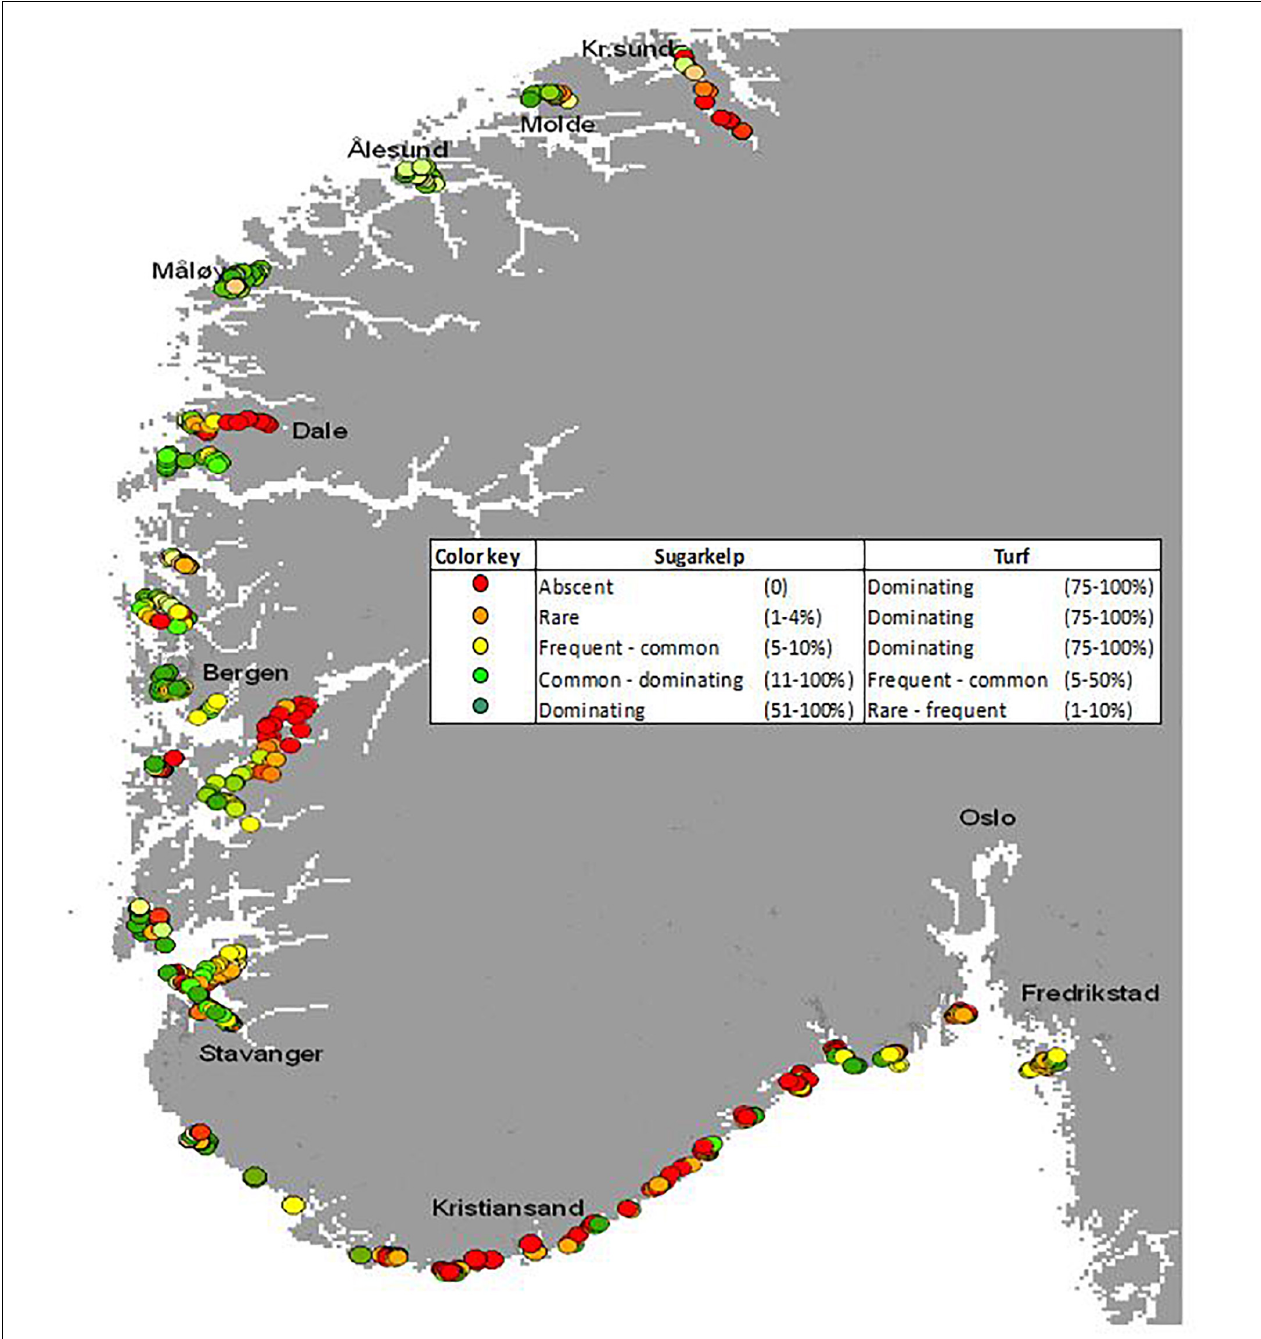
FIGURE 2 | Substrate coverage of both S. latissima and turf algae was recorded at more than 600 sites on the southern coast of Norway in the period 2005–2008. Semiquantitative abundance was determined using the following categories: absent, scattered (1–4% coverage of available and suitable substrate), frequent (5–10% coverage), common (11–50% coverage), and dominant (51–100% coverage). The state of each kelp site was evaluated based on the balance between the abundance of kelp and the abundance of turfs. These evaluations are indicated by the coloring, ranging from a good state with kelp domination (green) to a bad state with complete domination of turfs (red). Figure modified from Moy et al.